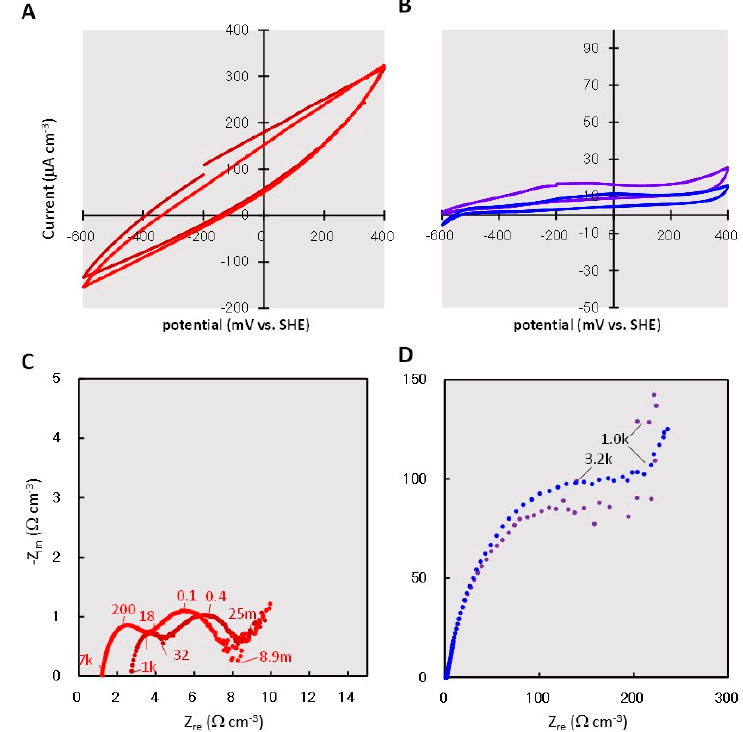
Figure 5. Cyclic voltammetry (CV) and electrochemical impedance spectroscopy (EIS) data for the rGO and GF complexes after polarization. A and B show CV data for the rGO complex ( A ) and GF complex ( B ). C and D are EIS data for the rGO complex ( C ) and the GF complex ( D ). Data for each are presented from two independent cultures, maintained in parallel. The numbers shown in graphs C and D are frequencies: f (Hz) = ω ·2 π − 1 .